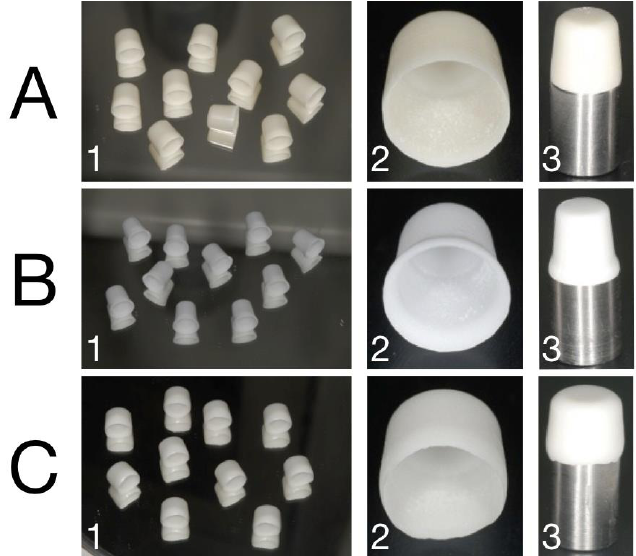
Figure 2. A1: Representative cluster of Group 1; A2: Detail of the slight-chamfer finish line; A3: Slight-chamfer zirconia coping on the proprietary metal abutment; B1: Representative cluster of Group 2; B2: Detail of the deep-chamfer finish line; B3: Deep-chamfer zirconia coping on the proprietary metal abutment; C1: Representative cluster of Group 3; C2: Detail of the knife-edge finish line; C3: Knife-edge zirconia coping on the proprietary metal abutment.